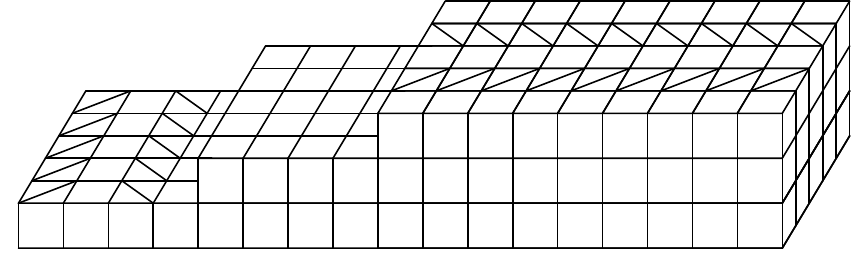
Fig. 12: Three layers of unit cubes, two of them contains cubes cut into